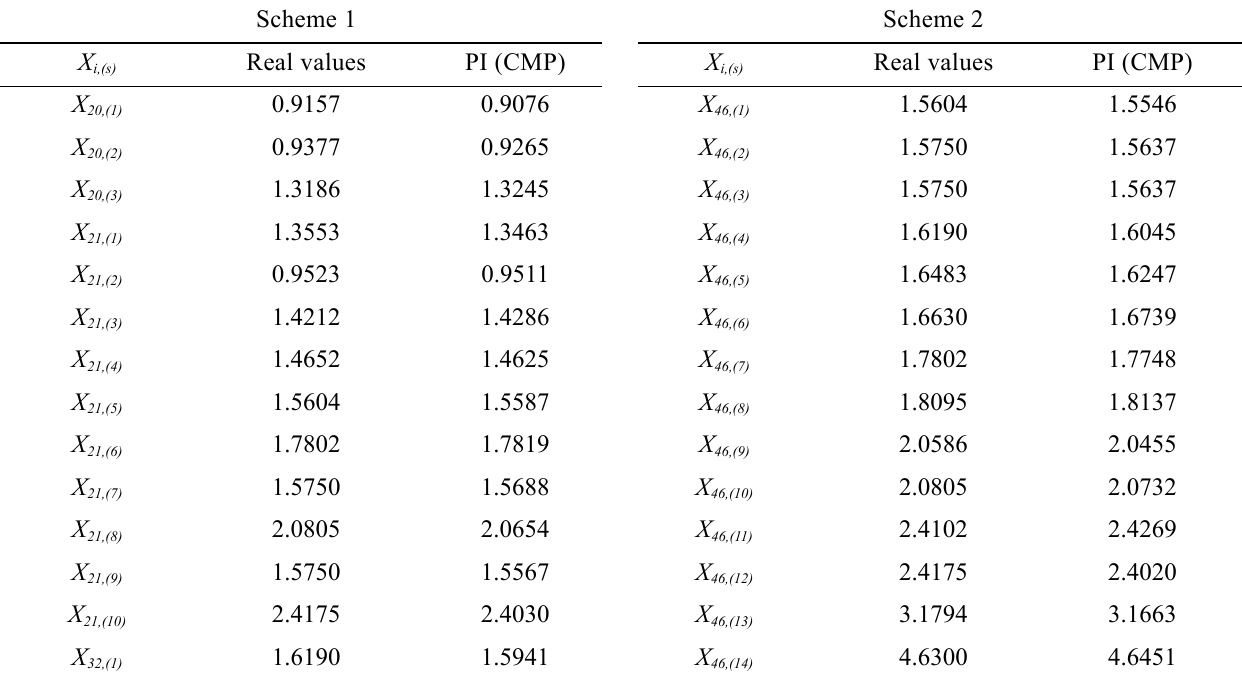
Table 3. Values of point prediction method for X i,(s) ; s=1, …, r i , (for scheme 1, i=20, 21, 32 and for scheme 2, i=46 ) and their real values. Scheme